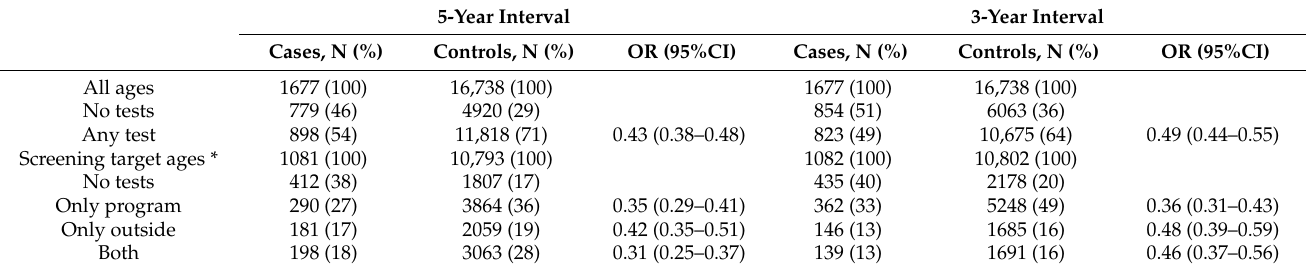
Table 2. Association between testing in a five- and three-year interval and cervical cancer diagnosis in the following five-year interval. Adjusted for education, socioeconomic status, and mother tongue. 5-Year Interval 3-Year